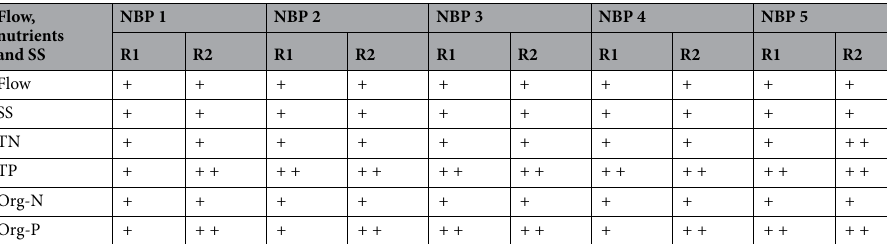
Table 2. Summary results of each NBP compared to NBP 0, for Biomass removal and Stand management attribute from MELA and Stakeholders (BMR-SM-MELA-STK). R1 represents attribute + RCP–4.5, and R2 shows attribute + RCP–8.5 for the entire period from 2031 to 2070, not for each decade as it was simulated. The symbol ‘ + ’ represents an increase of the scenario up to 10%, and ‘ + + ’ represents an increase of that scenario greater than 10%.